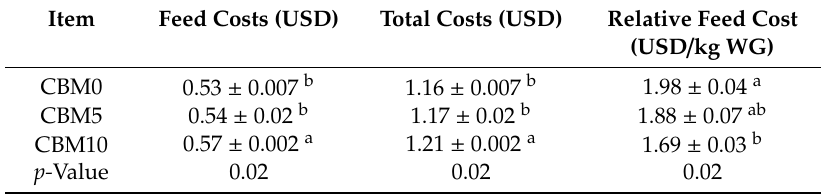
Table 3. E ff ect of dietary supplementation of cacao bean meal on economic e ffi